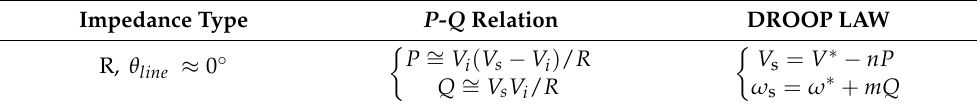
Table 1. Droop relation for the impedance type.